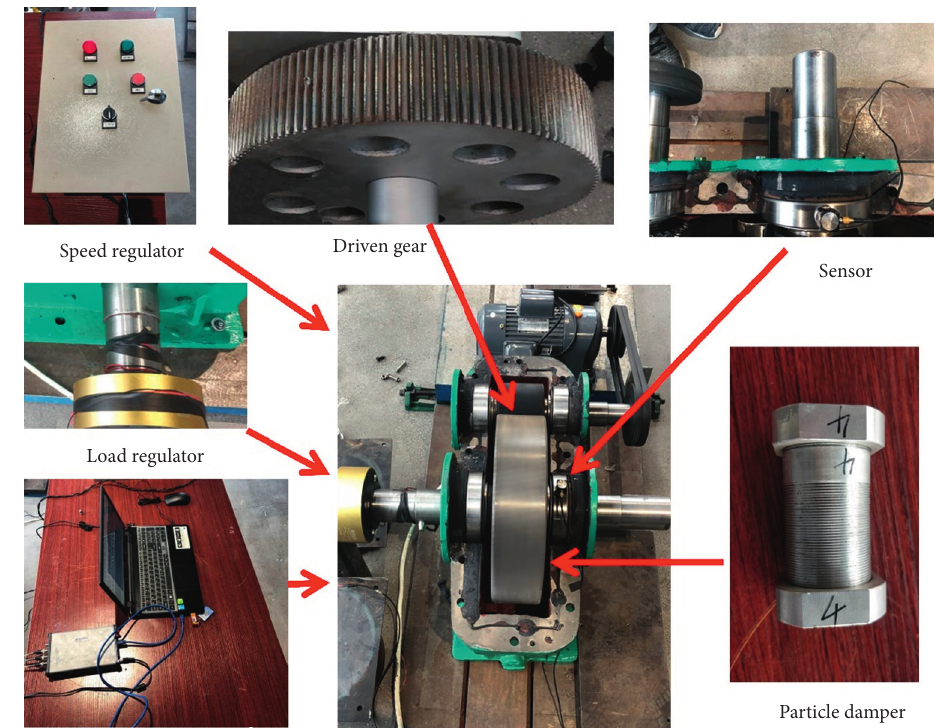
Figure 16: Gear transmission system test